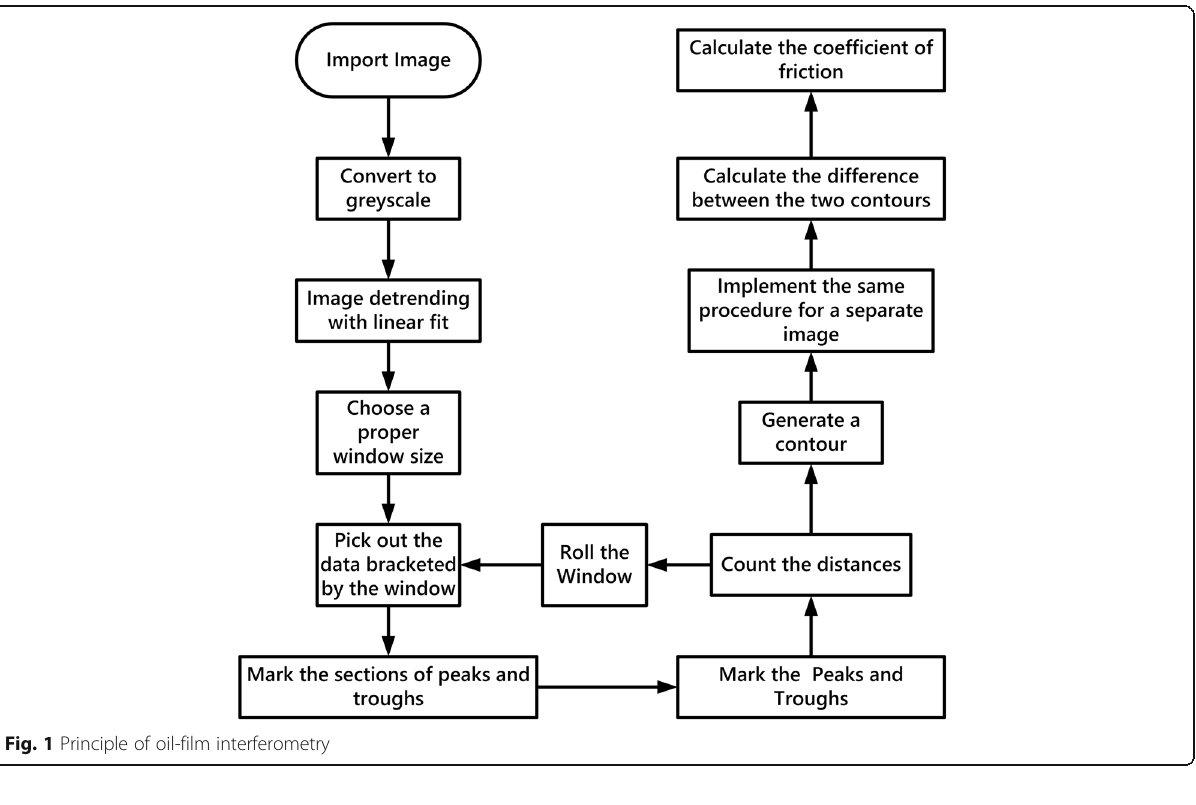
Fig. 1 Principle of oil-film